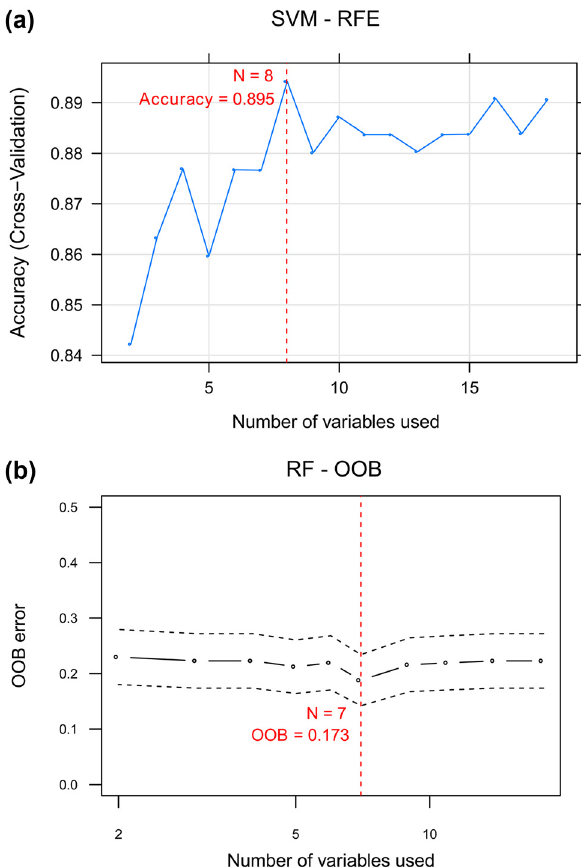
Figure 2: Feature lncRNAs selected by SVM – RFE ( a ) and RF – OOB ( b ) . The red dashed line shows the number of lncRNAs achieving the highest accurracy ( a ) or the smallest OOB error ( b )